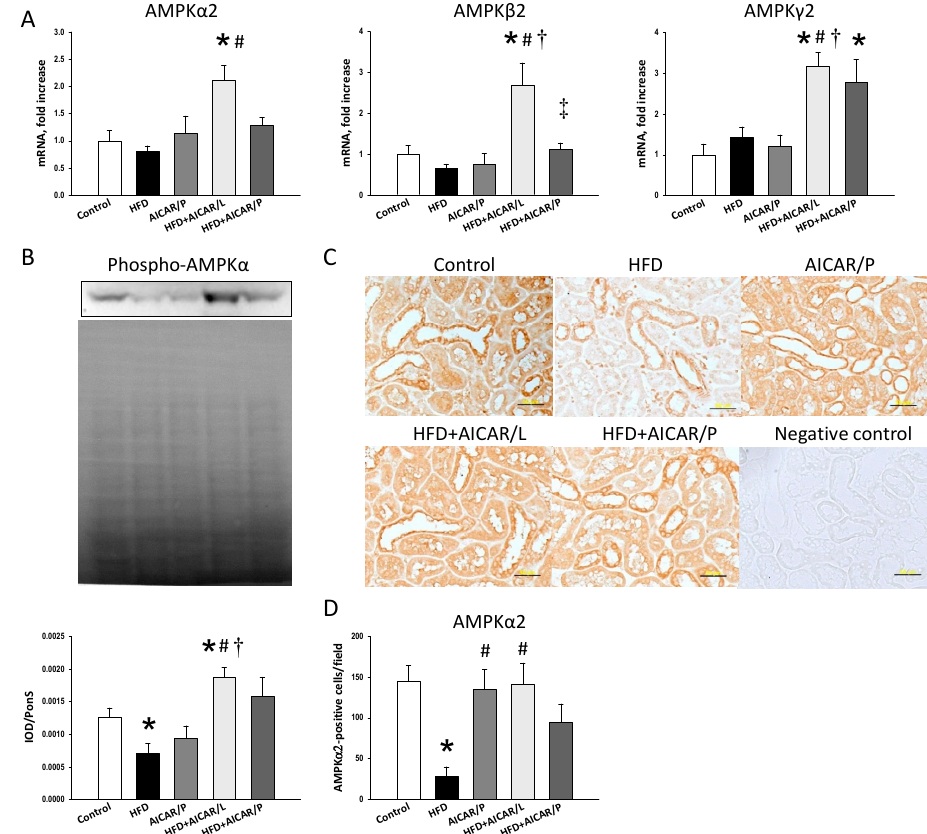
Figure 3. Effect of high-fat diet (HFD) and AICAR treatment in pregnancy (AICAR/P) or lactation (AICAR/L) on ( A ) mRNA expression of AMP-activated protein kinase (AMPK) α -, β -, and γ -subunits; ( B ) protein level of phosphorylated AMPK α (62 kDa) with represented blot and Ponceau S red (PonS) staining; ( C ) light microscopic findings of AMPK α 2 immunostaining in the kidney cortex in 16-week-old male offspring; and ( D ) quantitative analysis of AMPK α 2-positive cells per microscopic field (×400). Bar = 50 μ m; * p < 0.05 vs. control, # p < 0.05 vs. HFD, † p < 0.05 vs. AICAR/P.